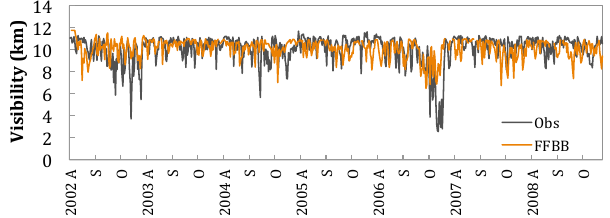
Figure 4. Comparison of daily visibility between GSOD observa- tion (black line) and FFBB-simulated results (orange line) in Singa- pore during the fire seasons from 2002 to 2008. A, S, and O on the x axis indicates August, September, and